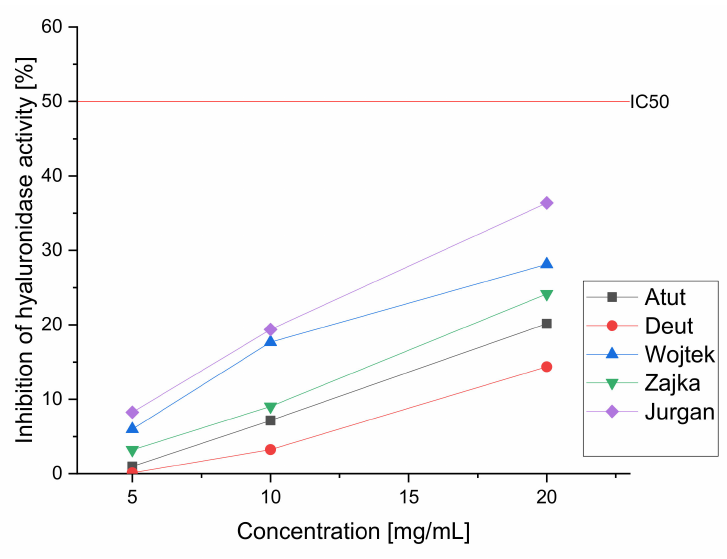
Figure 2. Inhibition of lipase activity by aqueous extracts of haskap berry